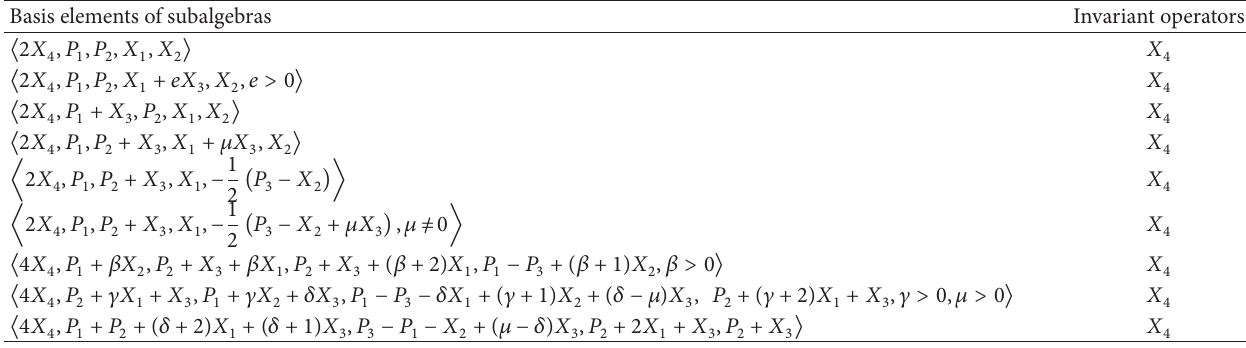
Table 17: Invariant operators of subalgebras of the type 𝐴 5,4 .